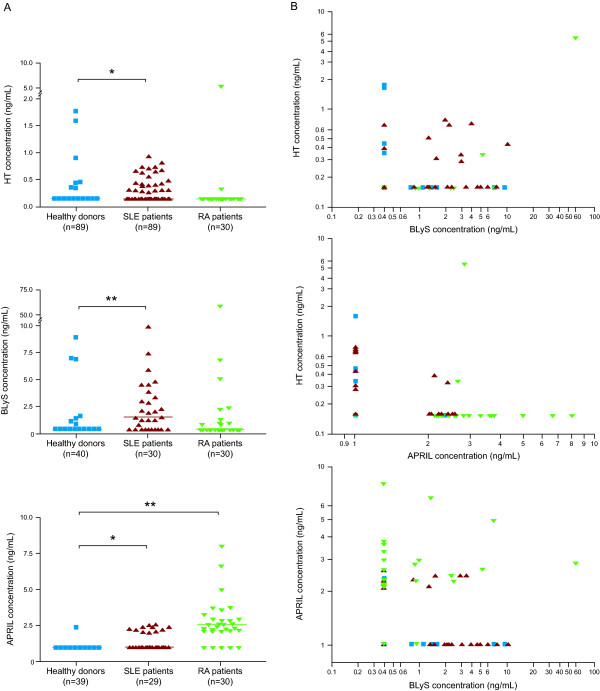
Serum levels of BLyS, APRIL, and HTs in healthy donors and patients with autoimmune diseases. (a) Serum concentrations of HTs (upper panel), BLyS (middle panel), and APRIL (lower panel) for each patient. Horizontal bars depict median values for each serum donor group: healthy donors (blue squares), patients with SLE (red triangles), and patients with RA (green inverse triangles). P values were determined by using Fisher's exact test. *P < 0.05, **P < 0.0001. (b) Bivariate plots showing serum levels of BLyS, APRIL, and HTs in healthy donors (blue squares), patients with SLE (red triangles), and patients with RA (green inverse triangles). For data plotting, samples with serum ligand levels below the LOQ were assigned values equal to half the LOQ for each assay (0.156, 0.39, and 1.0 ng/ml for HT, BLyS, and APRIL, respectively). APRIL, a proliferation-inducing ligand; BLyS, B-lymphocyte stimulator; HT, heterotrimer; LOQ, limit of quantitation; RA, rheumatoid arthritis; SLE, systemic lupus erythematosus.